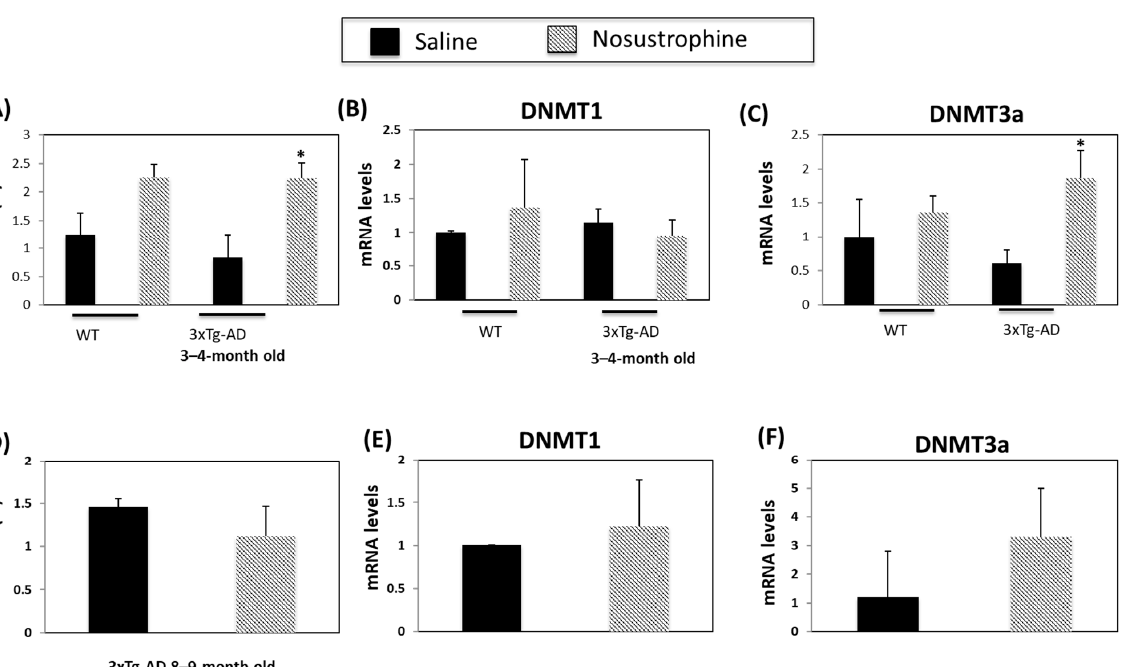
Figure 7. Nosustrophine regulates inflammation-related gene expression in older (8–9-month-old) trigenic AD mice. IL-1 β ( A ), Il-6 ( B ), TNFa ( C ), NOS3 ( D ) and COX-2 ( E ) mRNA levels were meas- ured by qPCR in hippocampus from 3xTg-AD mice ( n = 4 animals per group). Results are expressed as fold induction vs. saline-treated wild-type- or trigenic mice. Data are expressed as means ± S.E.M.